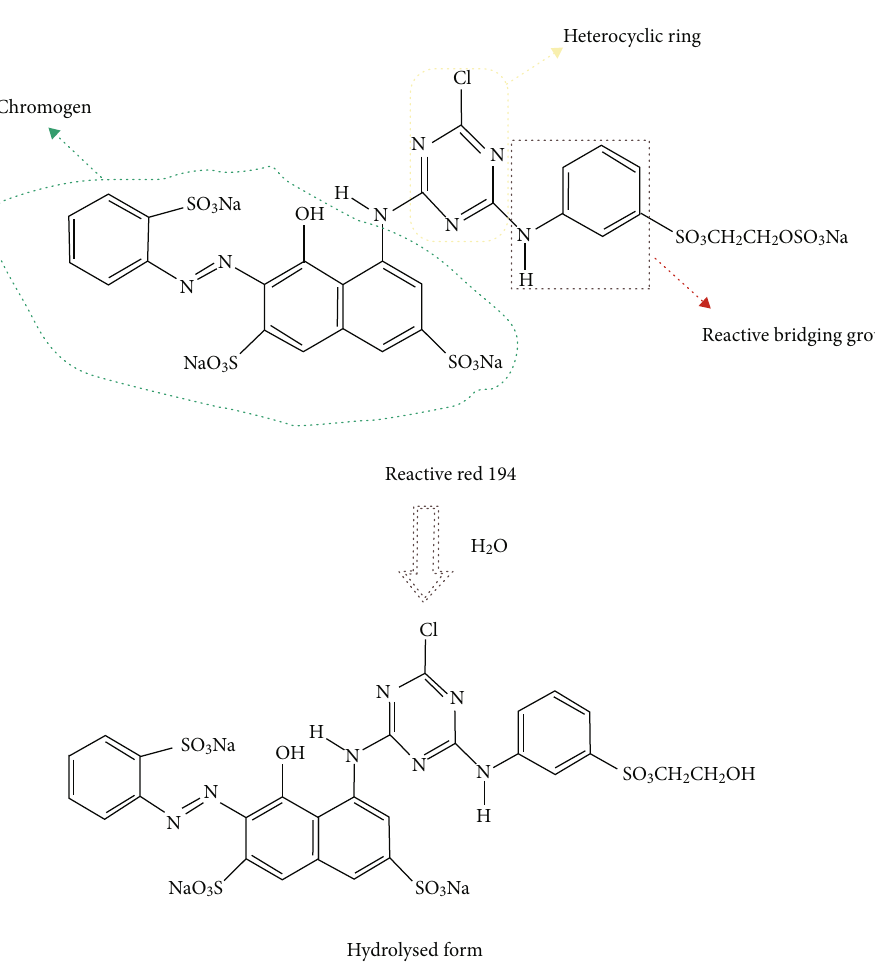
Figure 13: Nature of azo dyes during